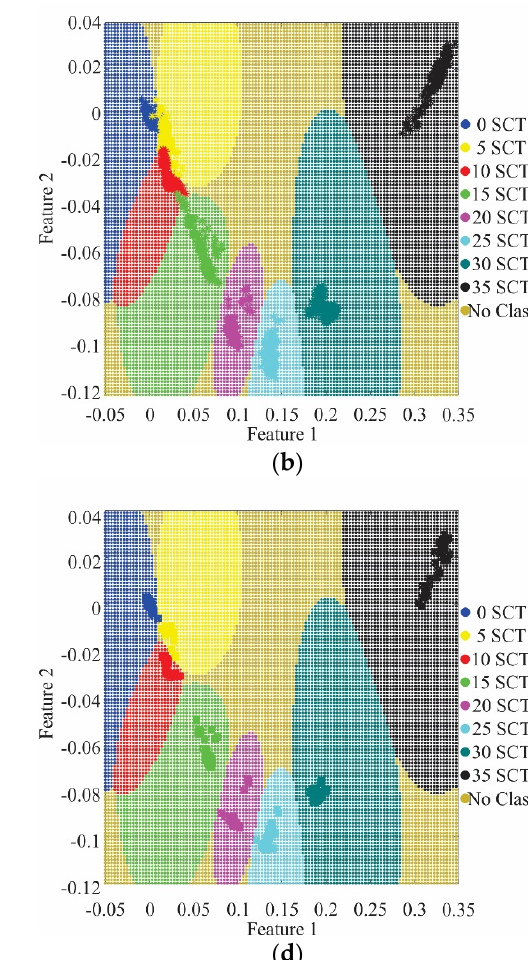
Figure 11. SVM classification: ( a ) dataset using 7 features; ( b ) projection of decision regions and his training data from a five-fold; ( c ) projection of decision regions and validation data from a k = 4; ( d ) projection of decision regions and validation data from k = 3. Table 3. Confusion matrix of SCTs classification using five-fold validation and k = 3.